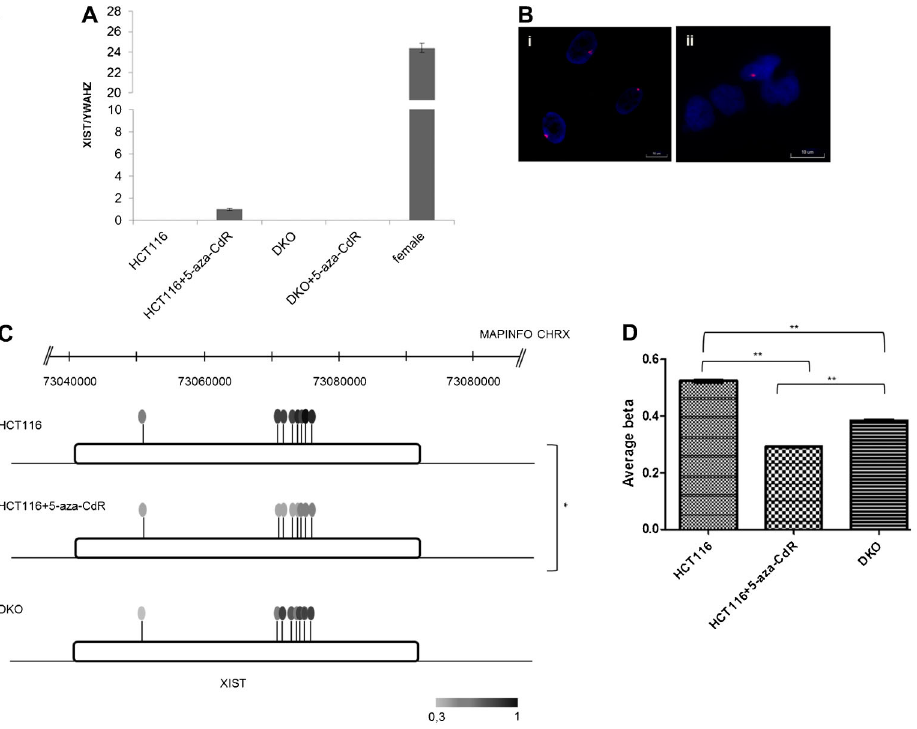
Figure 4. XIST expression. A , Relative expression levels of XIST RNA in HCT116 and a female cell line. The expression of YWAHZ was used as a reference. B , XIST RNA FISH in female cell line ( i ) and male HCT116 cell line treated with 10 m M 5-aza-CdR (5-aza-2 9 - deoxycytidine) for 96 h ( ii ). Nuclei were counterstained with DAPI (blue) and XIST RNA signals are red. The scale bar corresponds to 10 m m. C , XIST DNA methylation pattern by 8 CpGs (cytosine-phosphate-guanine) sites of 450K platform (cg15319295, cg12653510, cg05533223, cg117117280, cg20698282, cg17513789, cg02644889, and cg17279685). The color-ratio bar at the bottom indicates the methylation level. D , DNA methylation level of CpG sites related to X chromosome covered in the 450K platform; **P , 0.0001, Kruskal- Wallis test with Dunn’s multiple comparison post hoc